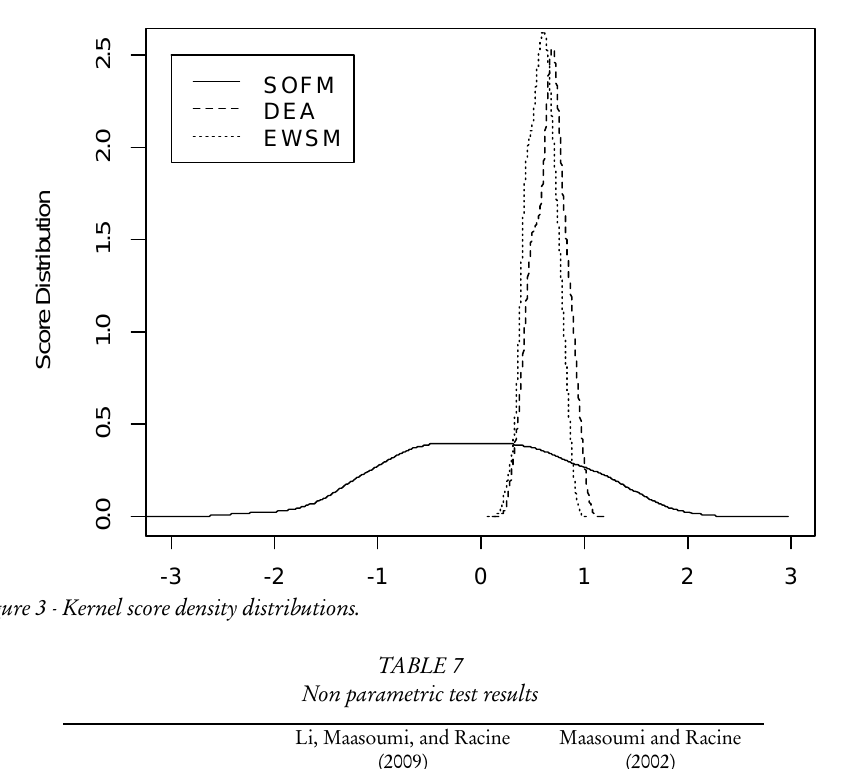
Figure 3 - Kernel score density distributions.